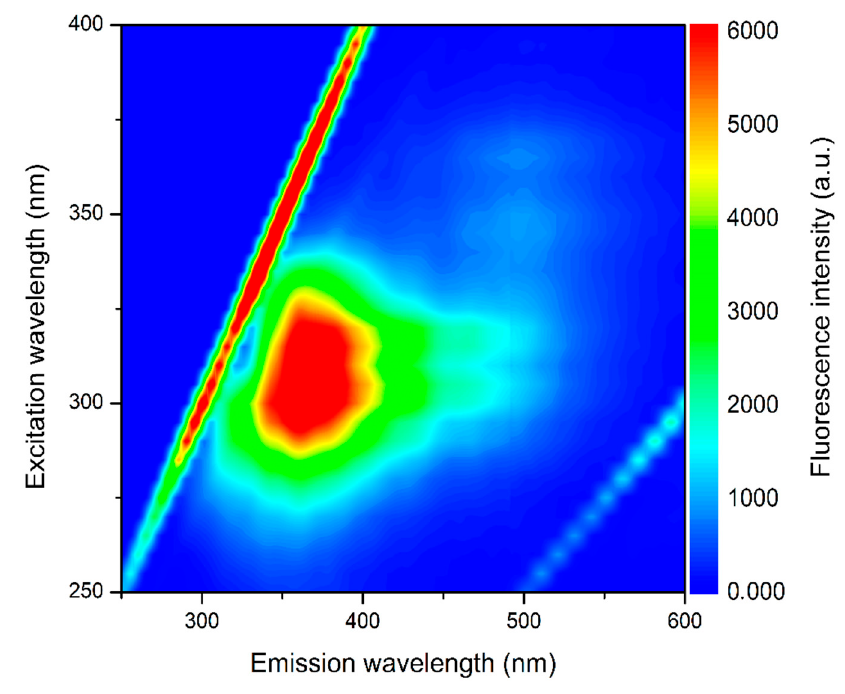
Figure 3. Emission–excitation map of buriti oil diluted in hexane at 5 g/L.